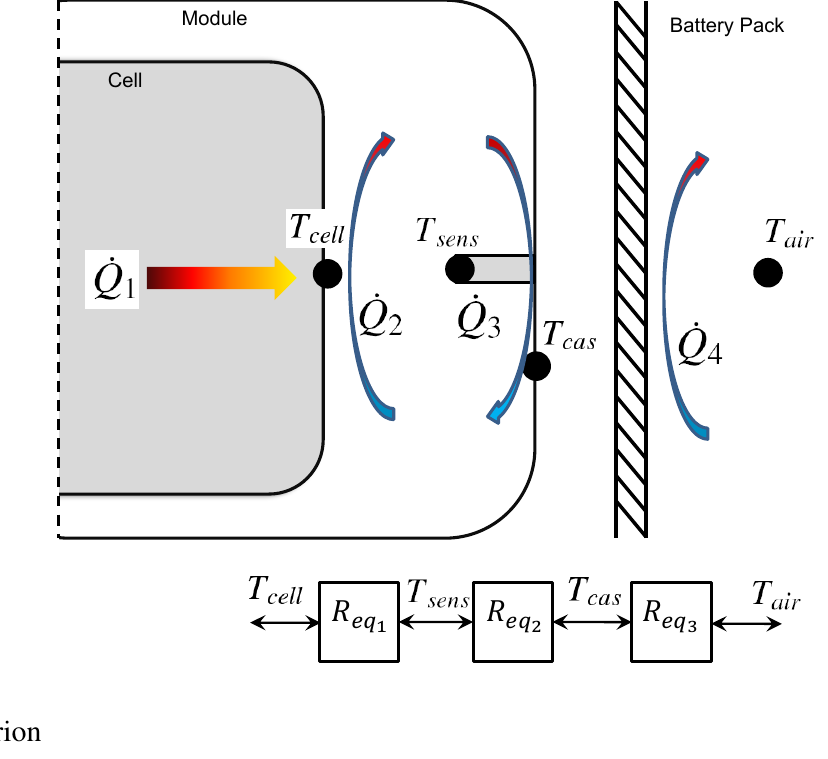
Figure 3. Heat flow transfers with equivalent resistance